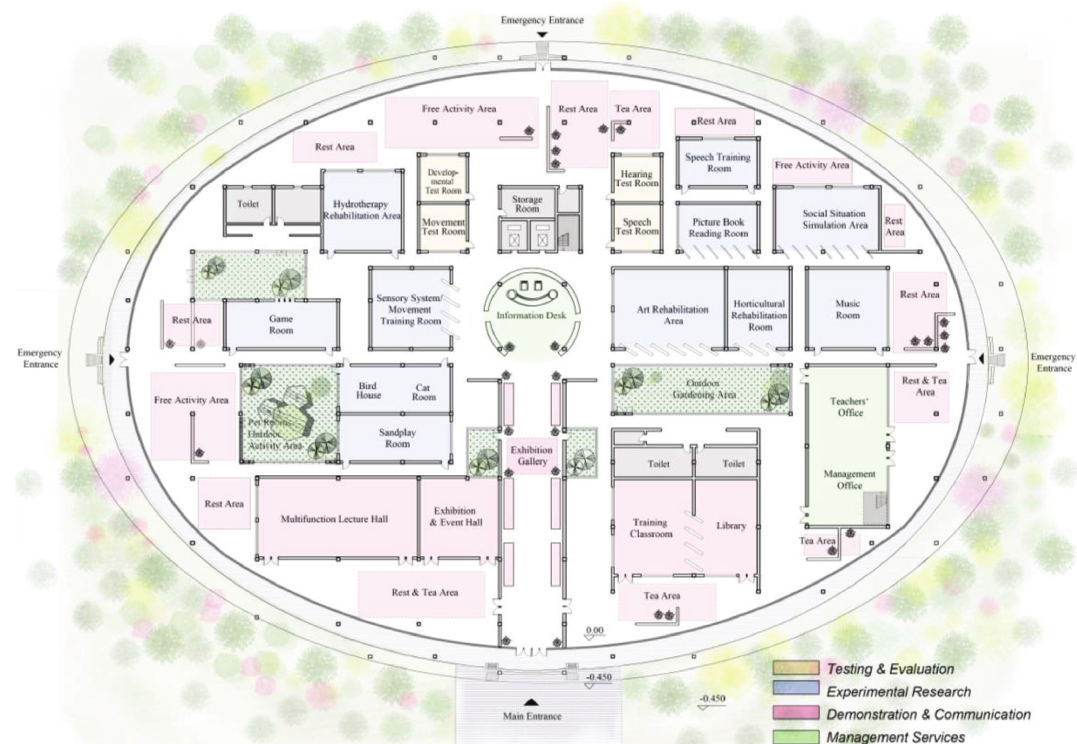
Figure 12: Function organization of four